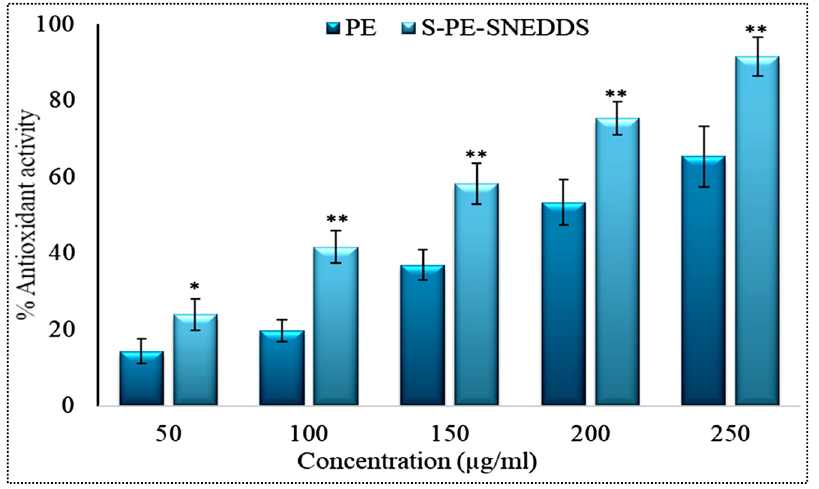
Figure 9. Comparative antioxidant profile of pure PE dispersion and optimized S-PE-SNEDDS formulation. Values are given as mean ± SD ( n = 3), * significantly different at p < 0.05 and ** p < 0.01.